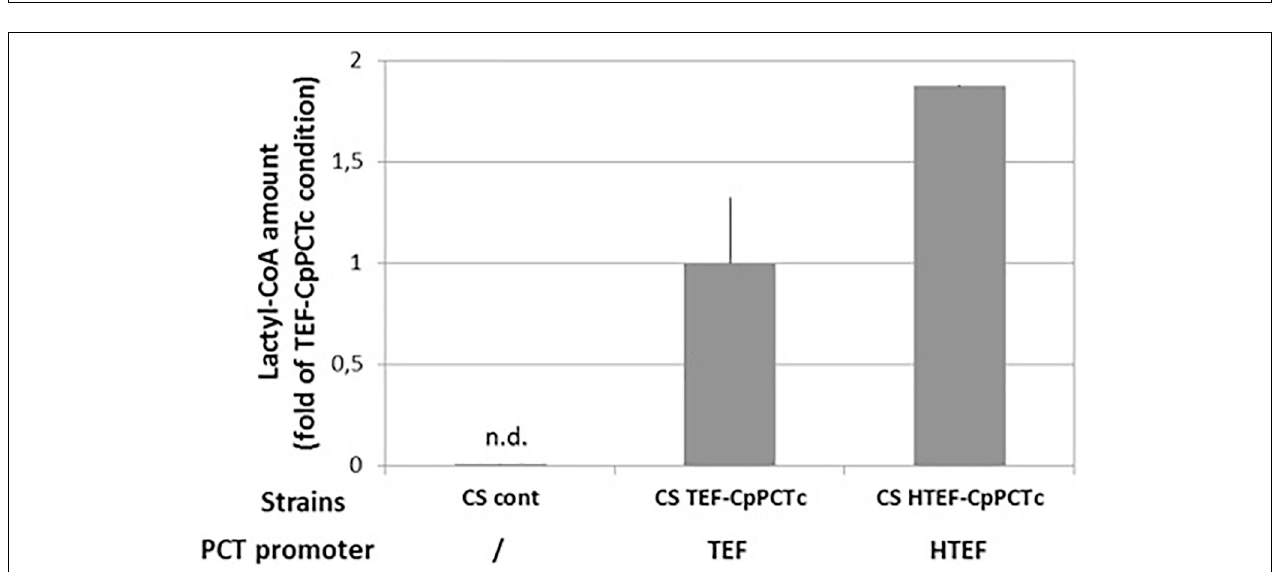
FIGURE 6 | Composition in lactic acid of PLA produced in vivo in CS TEF-CpPCTc + TEF-PaPHAp yeast strain after hydrolysis. PLA was extracted from CS + TEF-CpPCTc + TEF-PaPHAp strain after 5-day cultivation, then purified and hydrolyzed. The extracted solution was then analyzed by HPLC. This experiment is representative of three independent experiments.